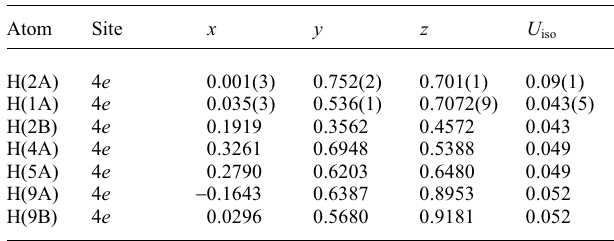
Table 2. Atomic coordinates and displacement parameters (in Å 2 )